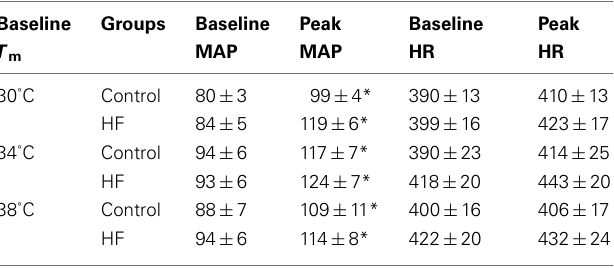
Table 3 | Baseline MAP (mm Hg) and HR (beats/min), and peak responses.